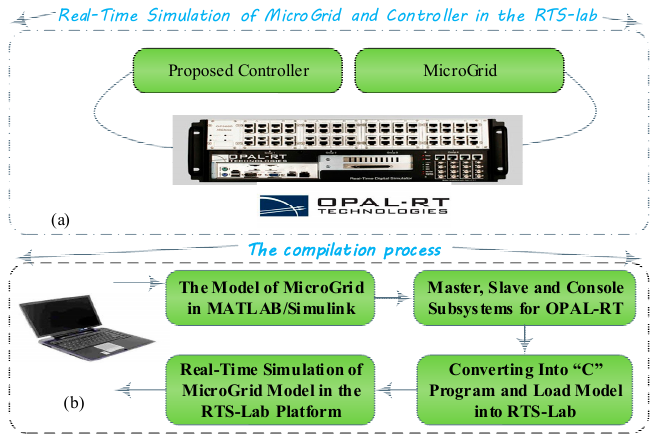
Figure 5. The real-time experimental setup; ( a ) the real-time simulation of MG and controller in the real-time simulator laboratory (RTS-LB) ( b ) the compilation process.